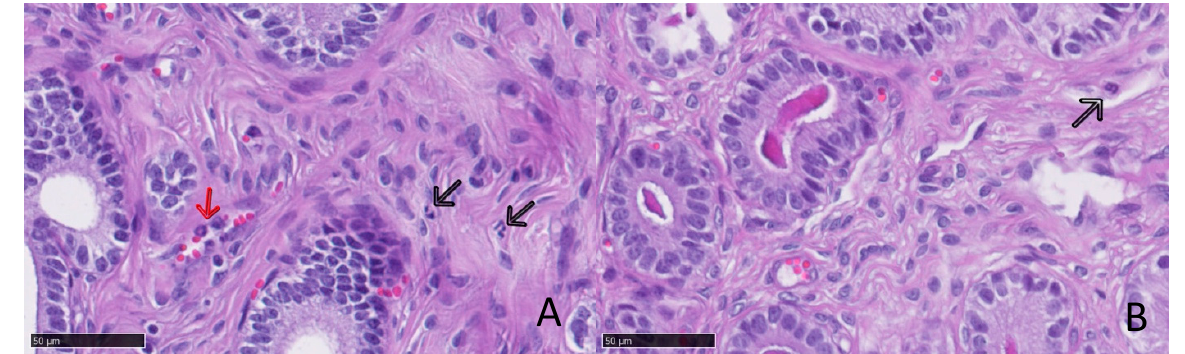
Figure 3. Glandular diameter in a queen’s endometrium. ( A ) Endometrial biopsy from a queen with low levels of serum progesterone (0.8 ng/mL). Black bars and boxes show the measures taken from the two perpendicular diameters of the gland (from the basal lamina to the opposite one), with a total mean of 33.5 mm in that queen. ( B ) Endometrial biopsy from a queen with high levels of serum progesterone (6.5 ng/mL). Black bars and boxes show the measures taken from the two perpendicular diameters of the gland (from the basal lamina to the opposite one), with a total mean of 98.99 mm in that animal. The glandular diameter values were significantly increased in animals with high levels of serum progesterone compared with the low progesterone group.